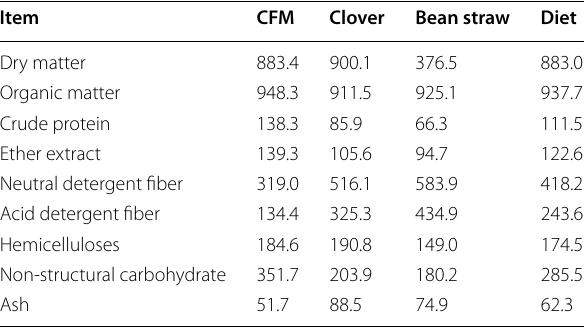
Table 1 The chemical composition of the ingredients and experimental diet (g/kg